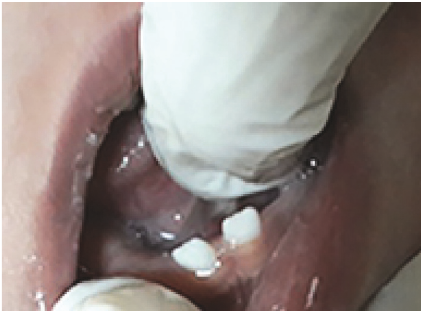
Figure 1: The patient’s mandibular anterior segment and erupted 71 and 81 numbered teeth.